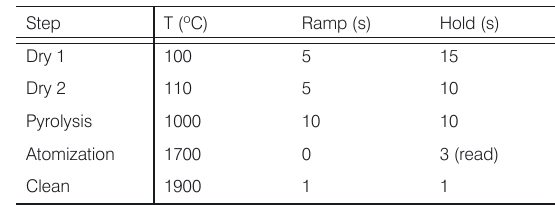
Table 1. Temperature programme for the determination of antimony using Pd-Mg(NO ) as chemical modifier. 3 2